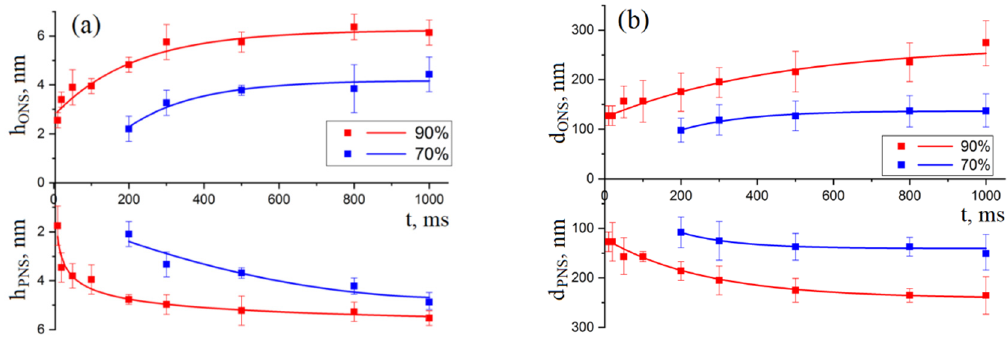
Figure 5. Dependences of the geometric parameters of nanostructures on the duration of the voltage. The amplitude of the applied voltage is 15 V, the feedback circuit current is 2 nA, the air humidity is 1—90 ± 1% and 2—70 ± 1%: ( a )—the height of the ONS and the depth of the PNS; ( b )—the diameter of the ONS and PNS.